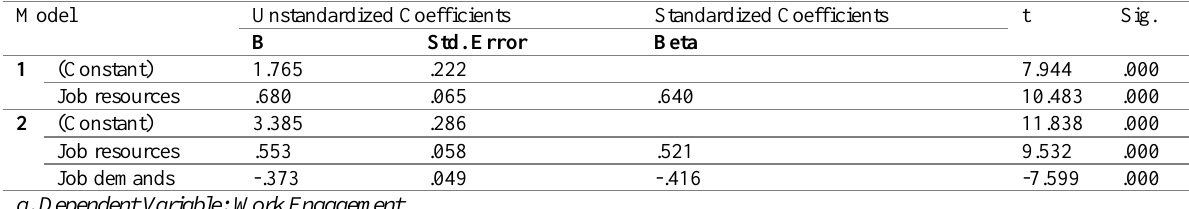
Table 7: Coefficients for the moderating effect of job demand Model